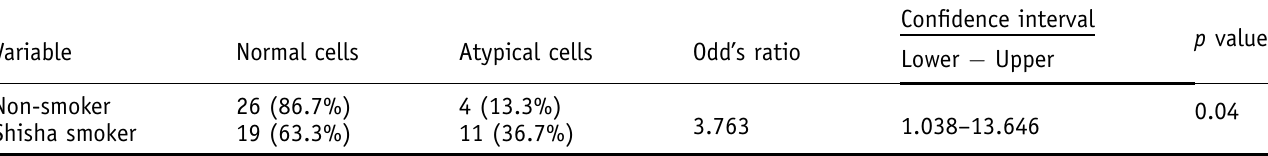
Table IV. Comparison of atypical cells among shisha smokers and non-smokers. Variable Normal